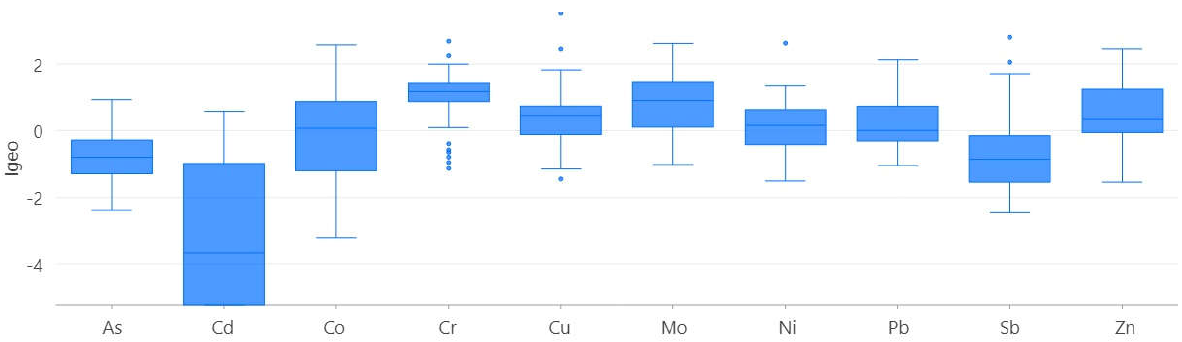
Figure 4. Igeo of metals and metalloids defined based on the determined regional geochemical back- ground.